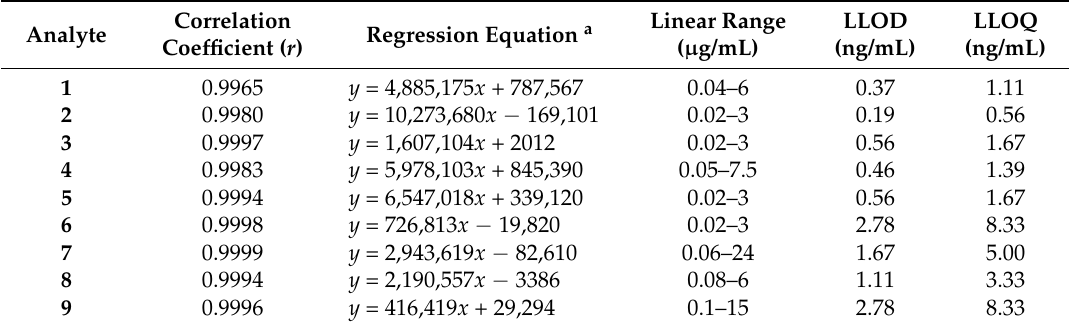
Table 1. Regression equations, correlation coefficients, lower limit of detection (LLOD) and lower limit of quantification (LLOQ) for the nine analytes.